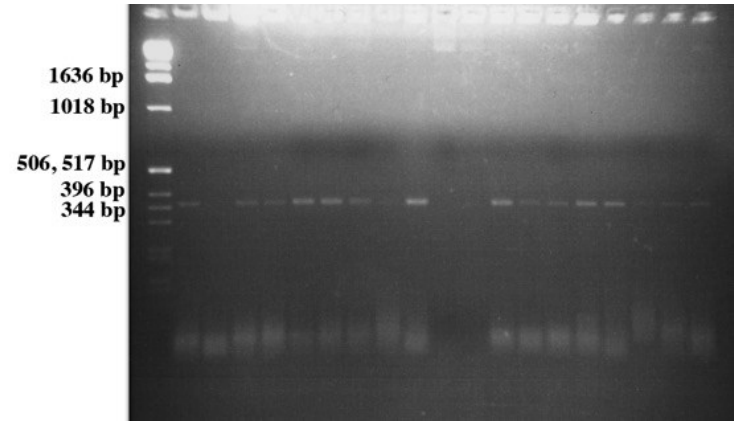
Figure 5. Representative agarose gel showing the PCR products using the GFP specific primers from cells recovered from the sampled tomatoes. Product size = 359 base pairs